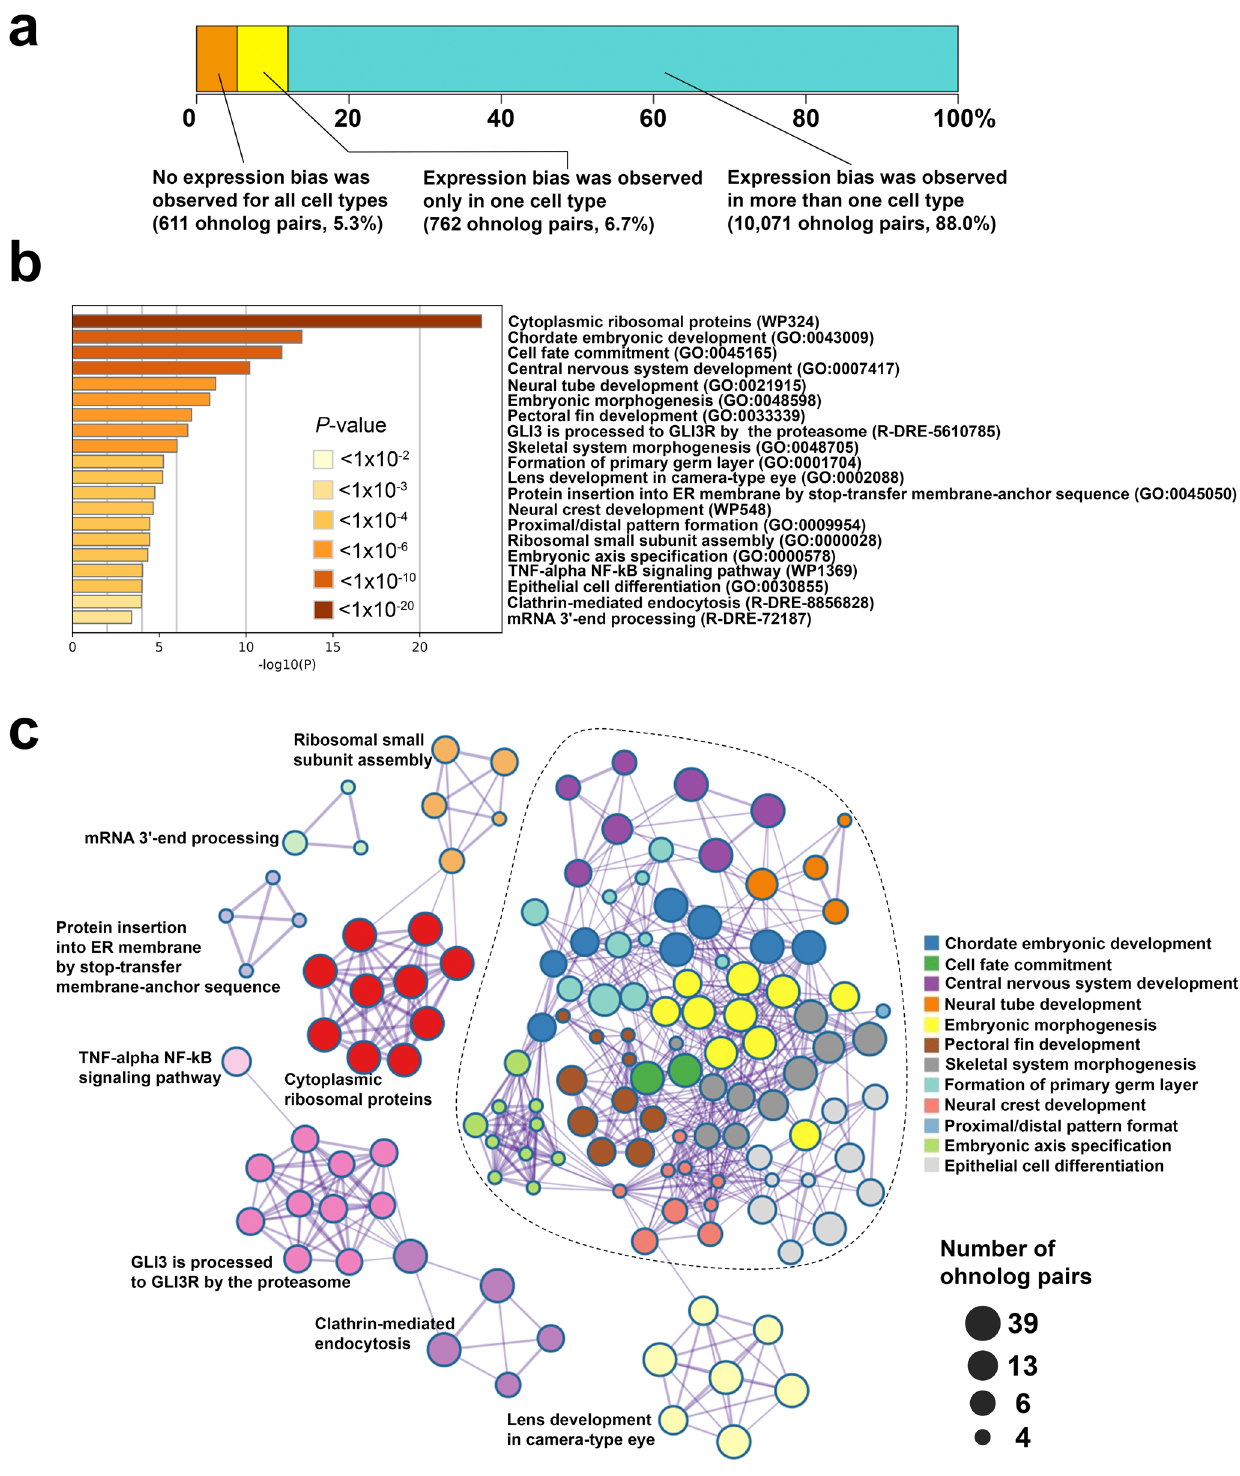
Fig. 4 Functional enrichment analysis of the ohnolog pairs with retained unbiased expression. a Of the 11,444 ohnolog pairs analyzed, 611 (5.3%) showed retained unbiased expression in each cell type (orange). For the remainder of the ohnolog pairs, expression biases toward one of the ohnologs were detected in one (yellow) or more (blue) cell types. b Functional enrichment analysis of the 611 ohnolog pairs that showed retained unbiased expression in each cell type. The x axis represents the negative log10-transformed P value based on the accumulative hypergeometric distribution 67 . The y axis represents the 20 biological categories. Deeper color of the bar plot means smaller P value. c Network representation of the statistically enriched categories in the functional enrichment analysis of the ohnolog pairs with retention of unbiased expression. The nodes represent the enriched categories and the edges are de fi ned based on the similarities among their gene memberships. The name of the cluster is adopted from the name of the cluster with the smallest P value among the biological categories contained in that cluster. The dotted line highlights the large complex cluster consisting of 12 clusters. The node size is proportional to the number of input ohnolog pairs grouped into each